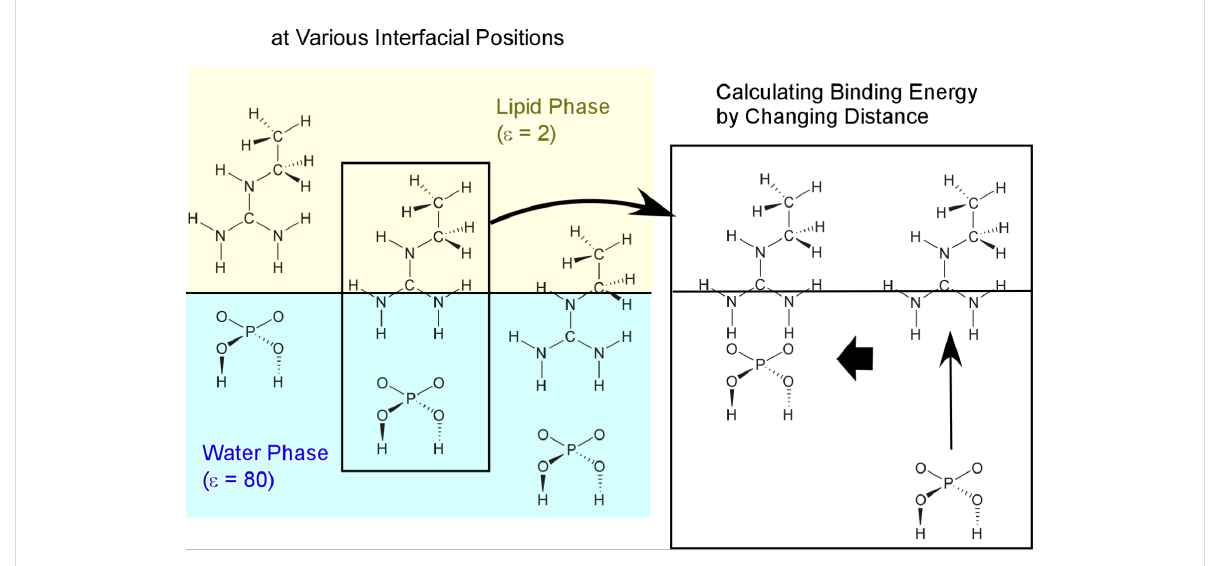
Figure 4: A model for calculations of the binding constant between guanidinium and phosphate at the air–water interface where the pair structures of phosphate and guanidinium are placed in a model of two phases with different dielectric constants of 2 (lipid phase) and 80 (water phase). The binding energy and binding constant was calculated while changing distance between guanidinium and